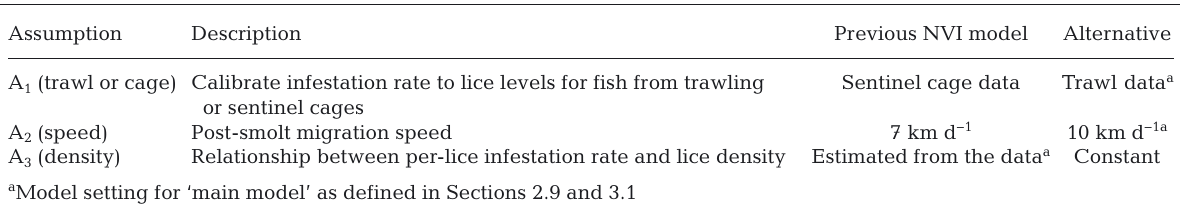
Table 1. Alternative model assumptions. For each of the assumptions A 1 to A 3 , salmon lice infestation level and salmon lice- induced mortality were calculated in accordance with either the modelling choice from the previous version of the